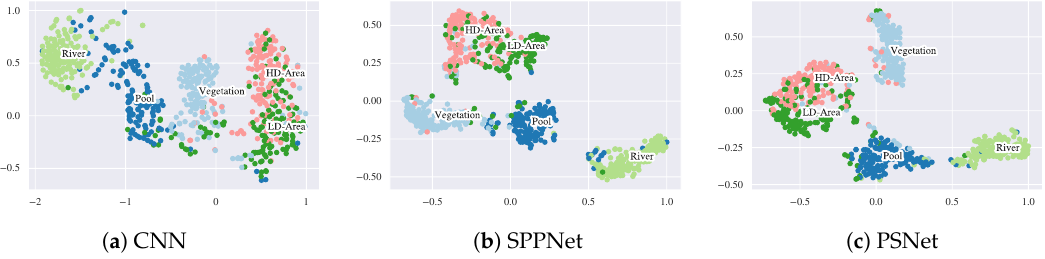
Figure 19. Feature visualization on the Guangdong dataset. The high-dimensional features, extracted by the first fully connected layer, are mapped into 2D space by the t-SNE.